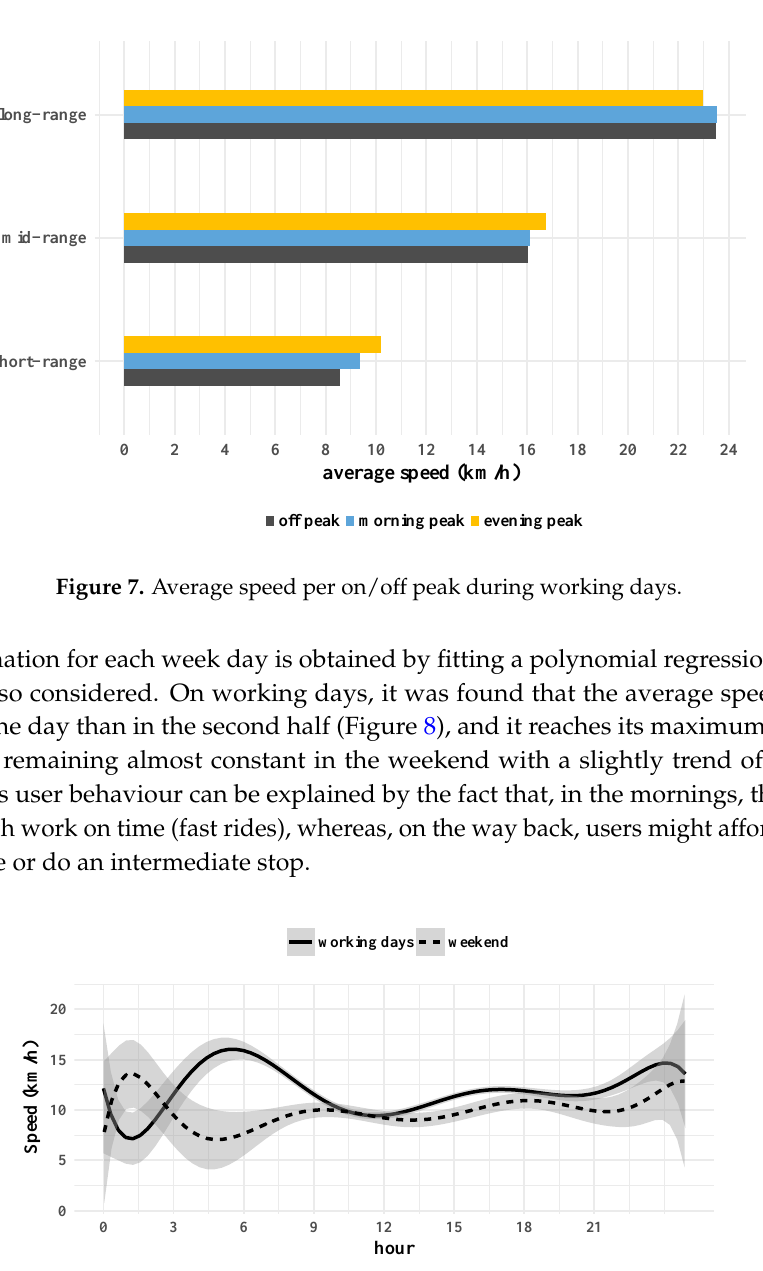
Figure 8. Speed estimation per hour of the day based on a polynomial regression, and confidence intervals are shown as grey